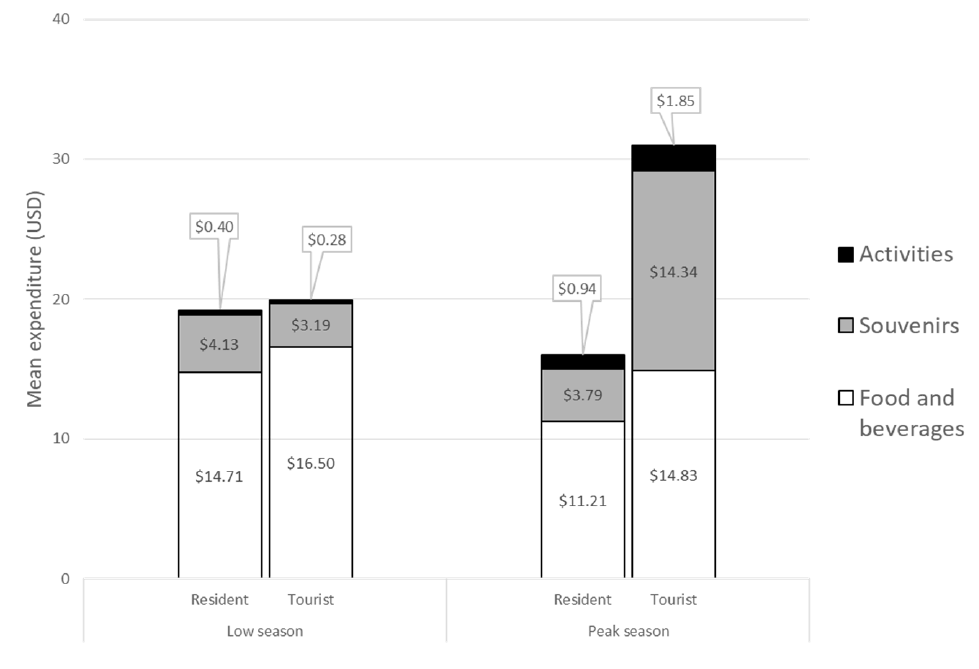
Figure 1. Mean expenditure (USD) of foreign resident visitors and foreign tourist visitors according to expenditure category.